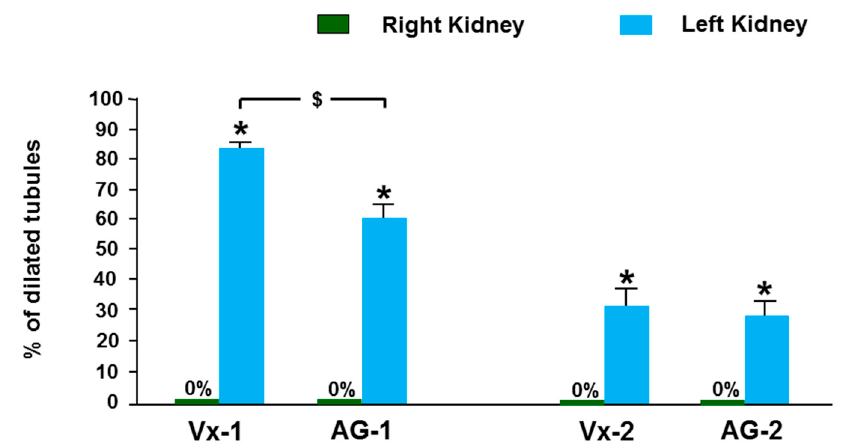
Figure 7. The degree of renal tubular dilatation in the right and left kidneys in all groups expressed as percentage. Values represent mean ± SEM. * indicates statistical significance between the right and left kidney within the same